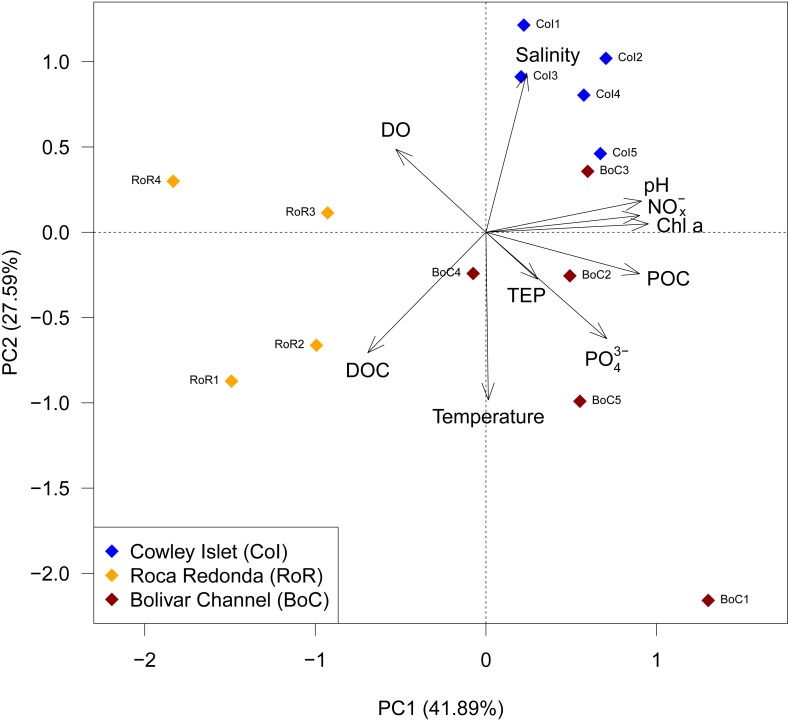
Principal component analysis (PCA) of observed water parameters at Cowley Islet (CoI), Roca Redonda (RoR), and Bolivar Channel (BoC).DO: dissolved oxygen; Chl a: chlorophyll a; PO\documentclass[12pt]{minimal}
\usepackage{amsmath}
\usepackage{wasysym}
\usepackage{amsfonts}
\usepackage{amssymb}
\usepackage{amsbsy}
\usepackage{upgreek}
\usepackage{mathrsfs}
\setlength{\oddsidemargin}{-69pt}
\begin{document}
}{}${}_{4}^{3-}$\end{document}43−, phosphate; NO\documentclass[12pt]{minimal}
\usepackage{amsmath}
\usepackage{wasysym}
\usepackage{amsfonts}
\usepackage{amssymb}
\usepackage{amsbsy}
\usepackage{upgreek}
\usepackage{mathrsfs}
\setlength{\oddsidemargin}{-69pt}
\begin{document}
}{}${}_{x}^{-}$\end{document}x−, nitrate/nitrite; DOC, dissolved organic carbon; TEP, transparent exopolymers; POC, particulate organic carbon.